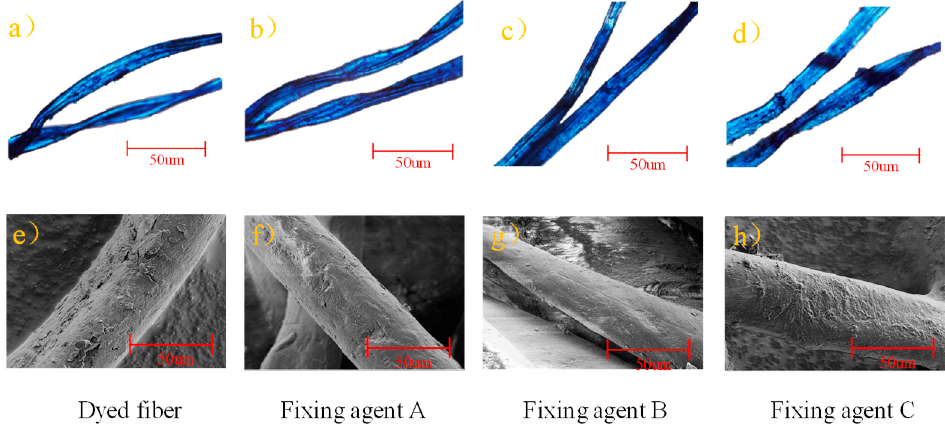
Figure 6. The optical morphology and SEM image of cotton fiber after fixing: ( a ) and ( e ) were the dyed control samples;( b ) and ( f ) were the dyed fibers treating with fixing agent A; ( c ) and ( g ) were the dyed fibers treating with fixing agent B; ( d ) and ( h ) were the dyed fibers treating with fixing agent